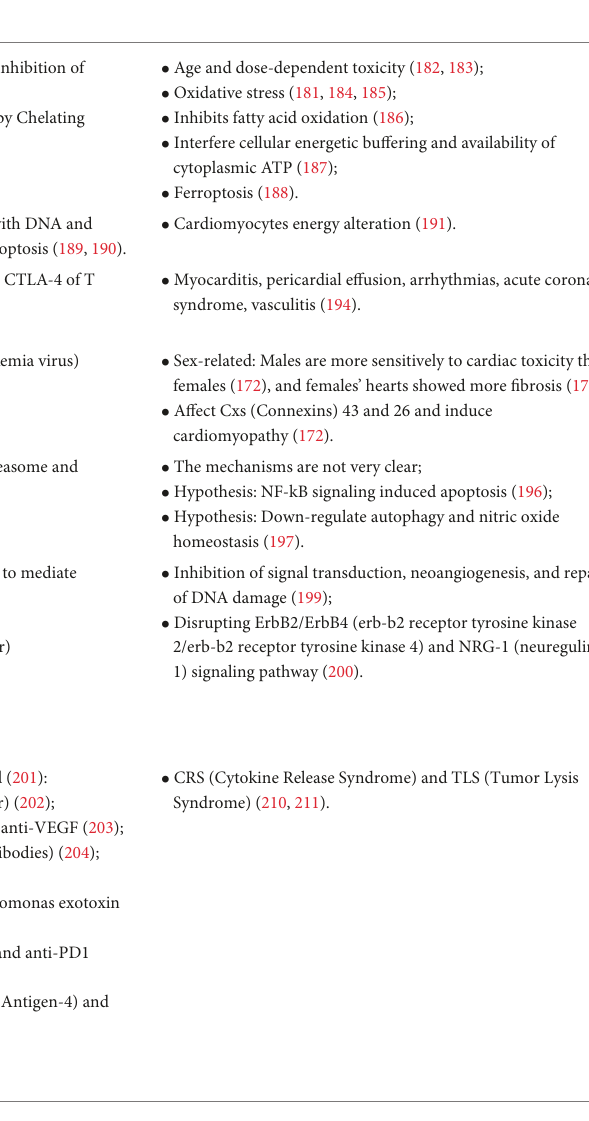
TABLE 2 Cancer therapy-induced heart